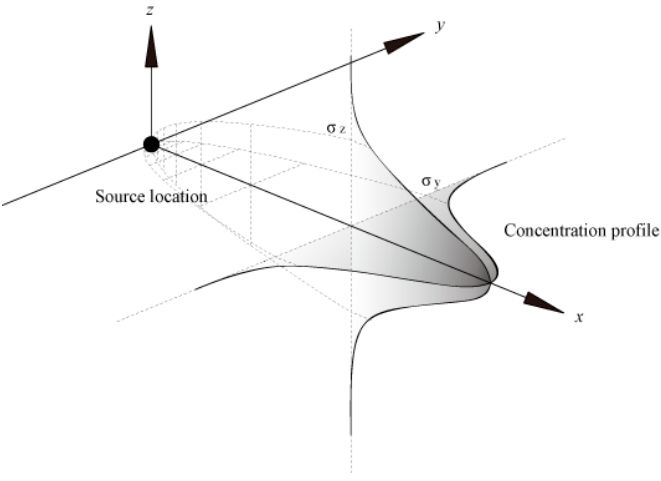
Figure 1. The Gaussian plume model, illustrating the basic concentration distribution.